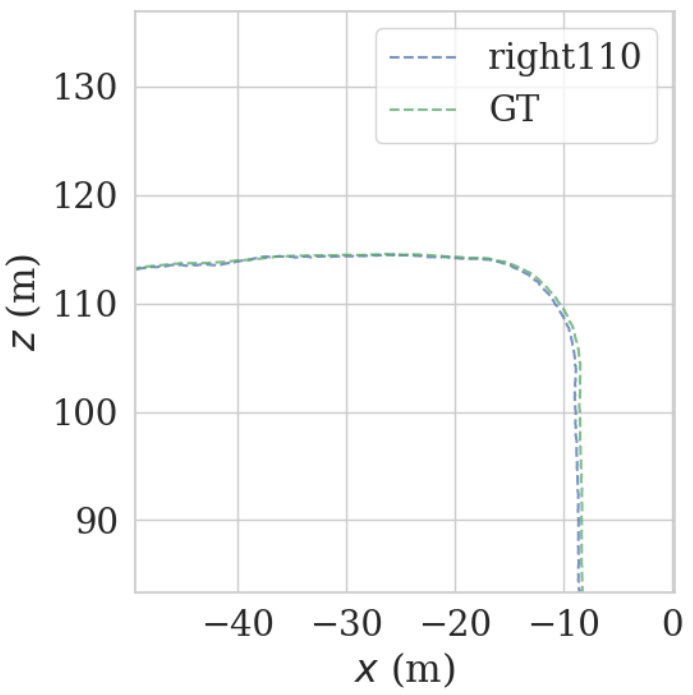
Figure 16. Track error using right LiDAR data at